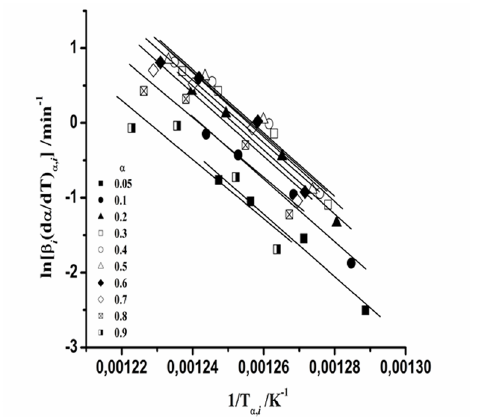
Figure 5 – The dependence of ln[ β i (d α /dT) α ,i ] versus (1/T α ,i ) at different values of α , for the crystallization process of the amorphous Fe 81 B 13 Si 4 C 2 alloy (full lines are the linear fitting (linearization) corresponding to different α ’s) Slika 5 – Zavisnost ln[ β i (d α /dT) α ,i ] nasuprot (1/T α ,i ) na razli č itim vrednostima α , za proces kristalizacije amorfne Fe 81 B 13 Si 4 C 2 legure (pune linije su linearno fitovanje ,linearizacija, koje odgovara razli č itim α